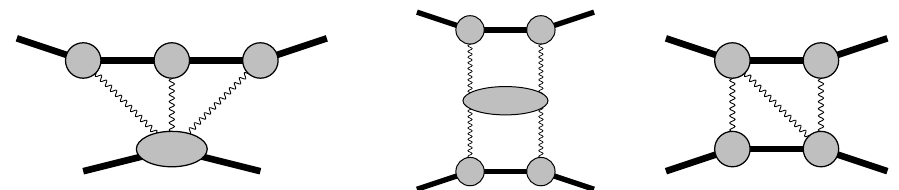
Figure 2. Spanning set of unitarity cuts relevant for the potential region O ( G 3 )